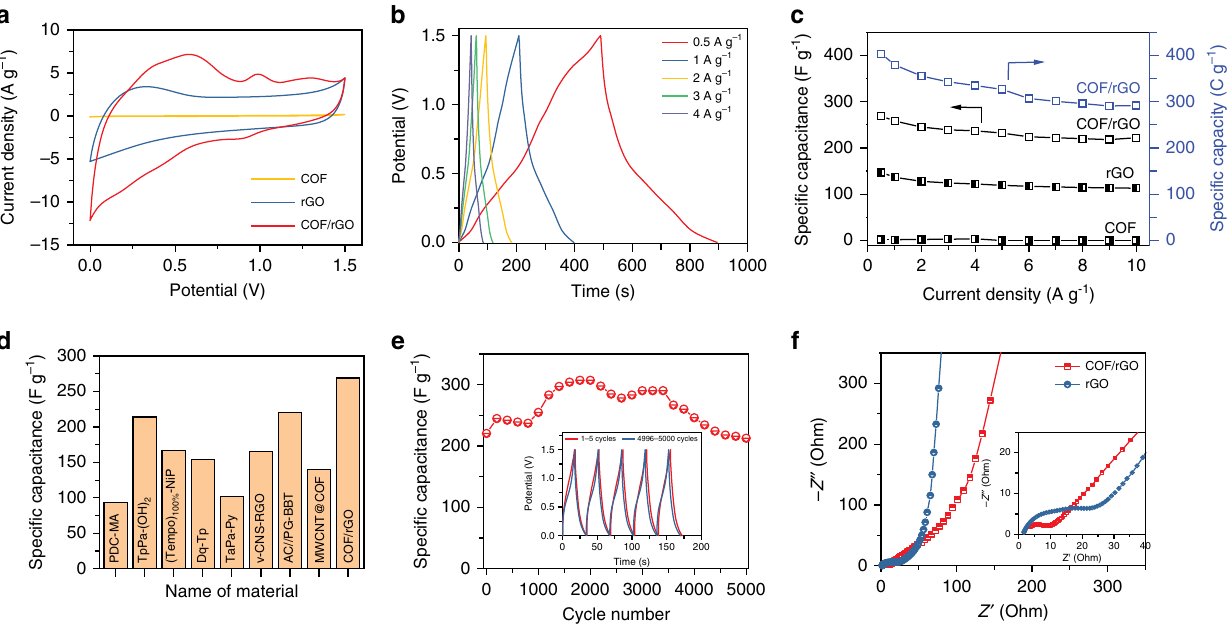
Fig. 4 Performance of COF/rGO electrodes in a symmetrical supercapacitor device. a CV curves for rGO, COF/rGO, and COF at 50 mV s − 1 . b The galvanostatic charge-discharge curves of COF/rGO at a current density of 0.5, 1, 2, 3, and 4 A g − 1 . c The speci fi c capacitances and capacities calculated from the discharge curves under different current density. d Comparative bar chart expressing the high performance of COF/rGO among all COF-based supercapacitors in two-electrode system. e The cyclic stability of COF/rGO at a current density of 8 A g − 1 . f Impedance spectra of the rGO and COF/rGO